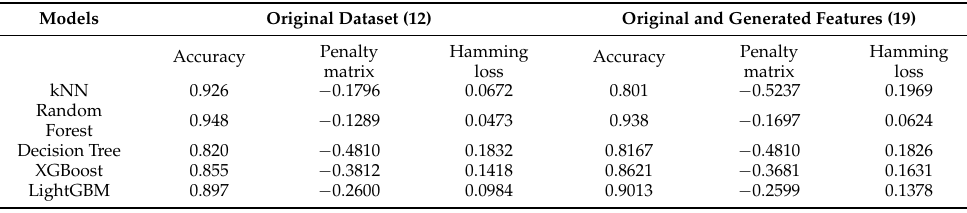
Table 7. By evaluating the precision information from Table 7, we noticed that the lowest value were computed for Dolomite (4) and Coal (10). A reason for such values could be the lack of representation of these lithofacies classes in the dataset. Table 6. Comparison of three scores models on the test dataset. Models